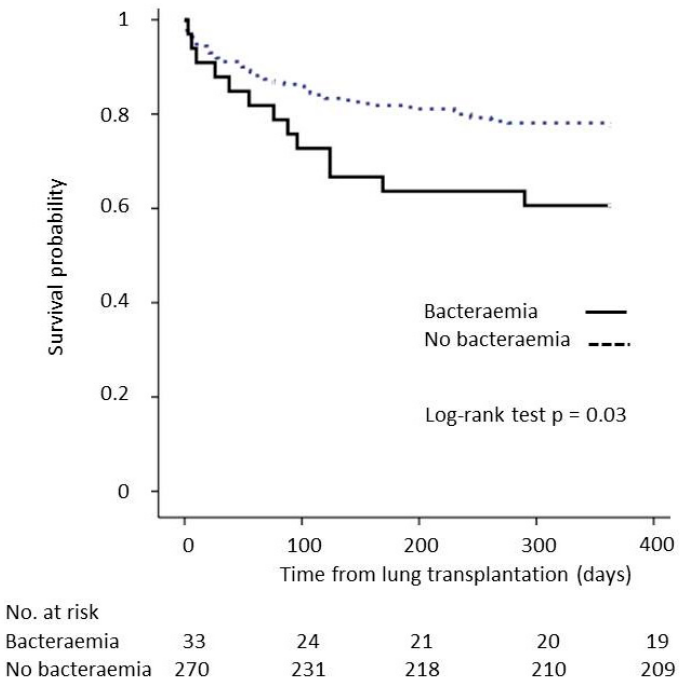
Figure 2. Impact of bacteraemia occurring during the posttransplant ICU stay on 1-year